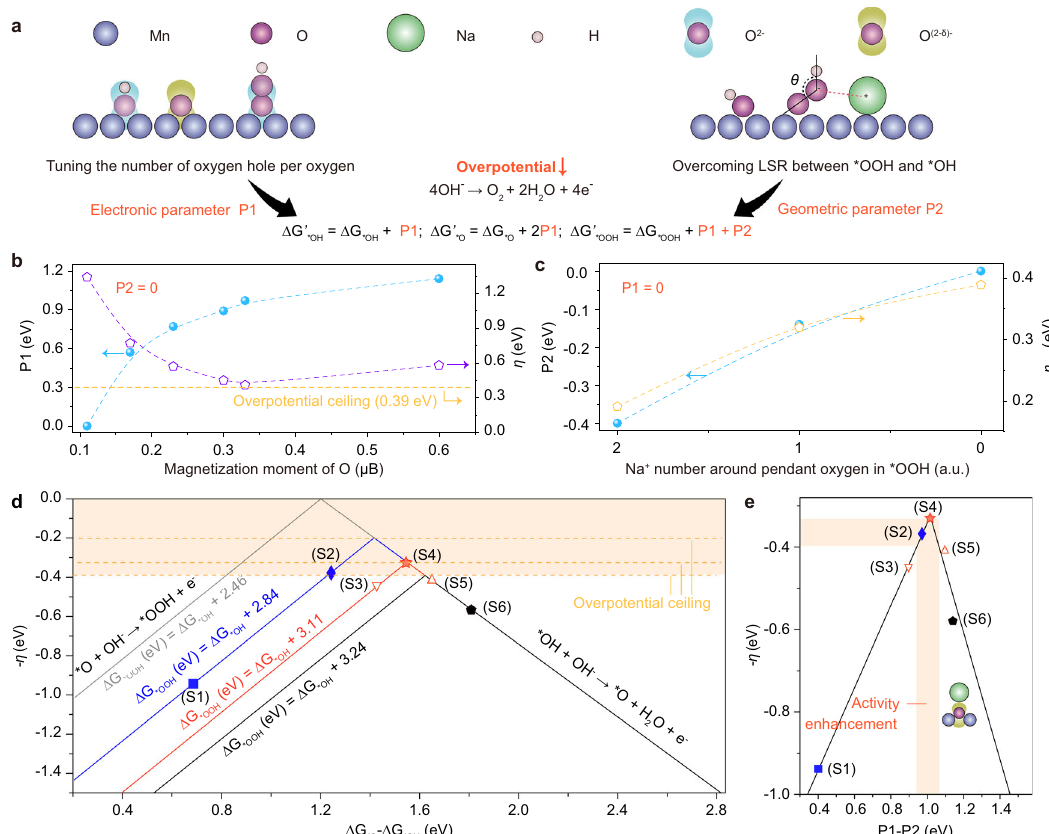
Fig. 2 Constructing better OER electrocatalyst through tuning the lattice oxygen reactivity and scaling relation. a Scheme of rational design of better Na x Mn 3 O 7 electrocatalysts. b Shifts in P1 to regulate the theoretical overpotential ( η ) by tuning the magnetization moment of O. c Shifts in P2 to reduce the overpotential ceiling ( η min ) by tuning Na + -speci fi c noncovalent interaction to overcome the LSR. d Dynamic volcano plot ( η versus Δ G * O – Δ G * OH ) derived from the rebuilt LSR. e Uni fi ed volcano plot ( η versus P1 – P2) using a binary descriptor of P1 –